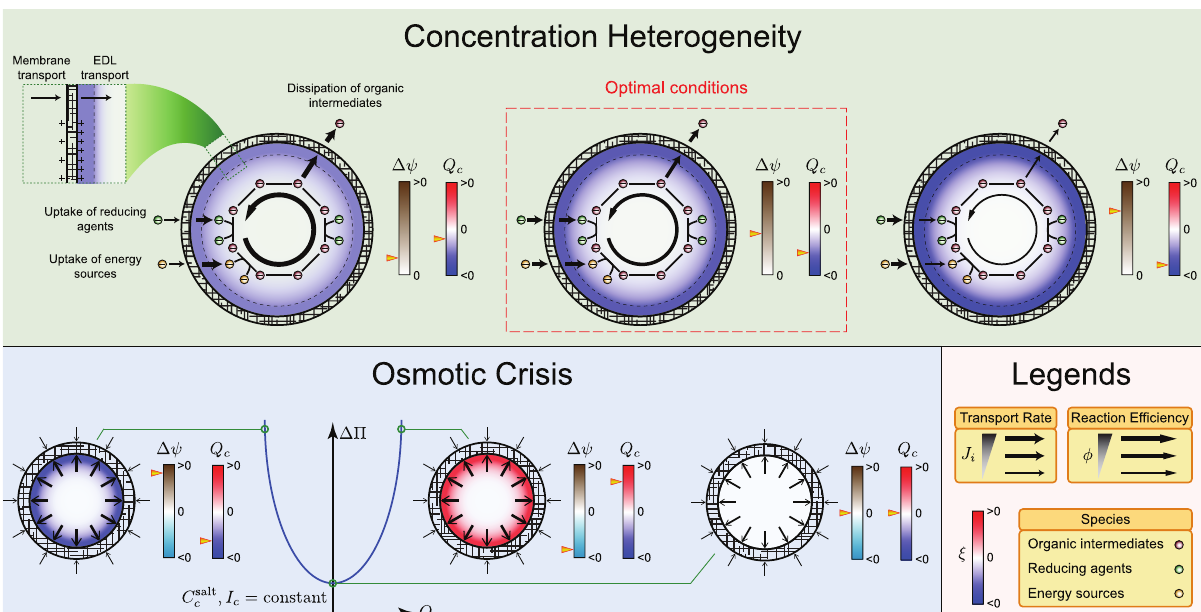
Fig 4. Selective advantages provided by electroneutrality. Selective pressures are examined in a protocell model (Fig 1), in which primordial reactions occur. Large positive membrane potentials Δ ψ increase the transport rate of negatively charged reducing agents and energy sources, while attenuating the dissipation of the organic intermediates of metabolic reactions. They also induce a nonuniform positive electric-potential field, elevating the concentration of anions in the cell. The resulting negative charge-density distribution ( ξ ( r ) < 0) leads to heterogeneous concentration distributions for charged reactive species, which in turn diminish reaction efficiencies. Small membrane potentials do not affect the reaction efficiencies significantly. However, they can not alleviate the dissipation of the organic intermediates as effective either. Therefore, parameter values furnishing an intermediate range of positive membrane potentials would have been optimal for the operation of early metabolic cycles. Moreover, if the total salt concentration C salt c and ionic strength I in the cell are held constant, then violation of electroneutrality (| Q | > 0 with Q the total charge in the cell) increases the osmotic c c c pressure differential Δ P across the membrane. Hence, electroneutrality could have minimized catastrophic events in primitive cells due to osmotic crisis, promoting the evolution of complex metabolic networks by providing structural stability. Electric double layer is denoted